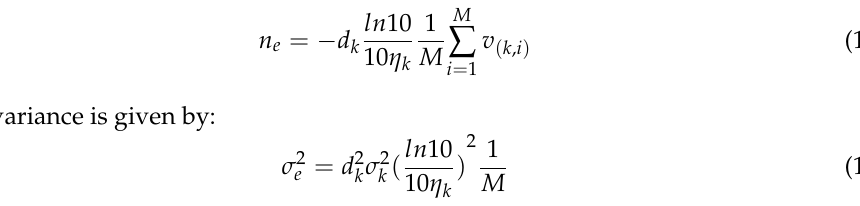
 and M for 5 d  . e k